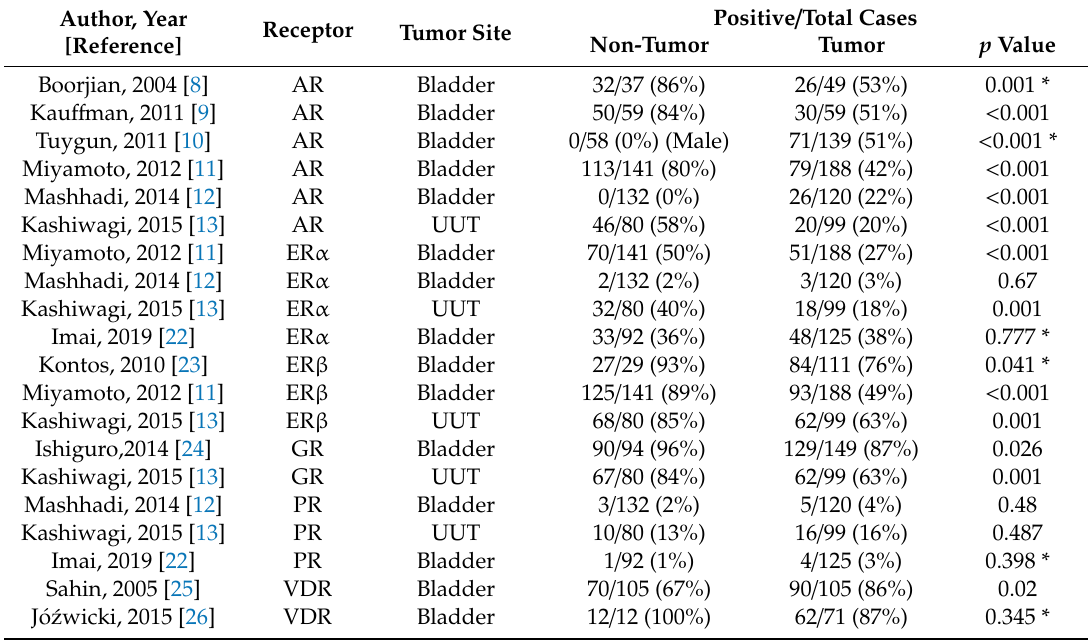
Table 1. Immunohistochemical studies for the expression of steroid hormone receptors in non-neoplastic urothelium versus urothelial carcinoma